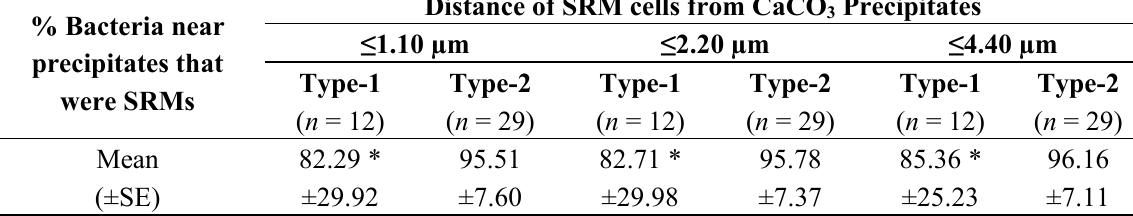
Table 1. Microspatial proximity between SRMs and CaCO Type-2 mats. Table shows percentages of total bacteria, located within 1.1, 2.2, or 4.4